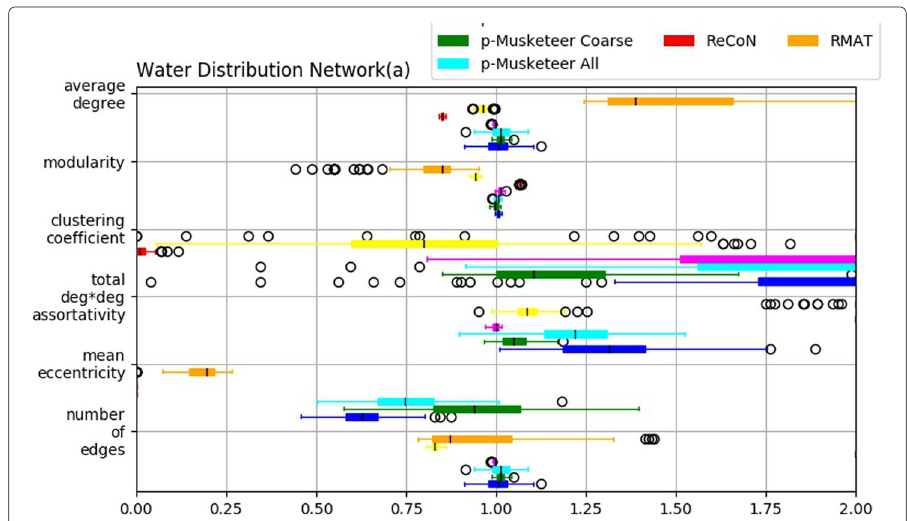
Fig. 6 Computational results on performance of planar Musketeer on real water network with 407 nodes and 459 edges for clustering coefficient, number of edges, mean eccentricity, total degree *degree assortativity, modularity and average degree